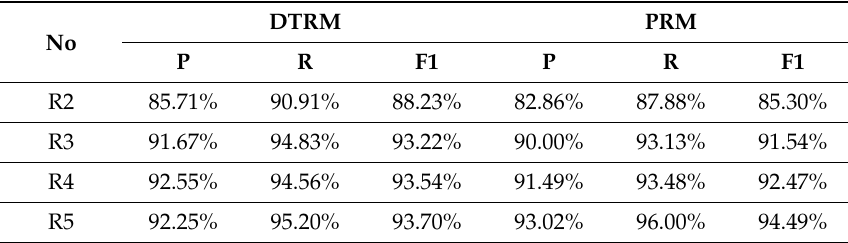
Table 4. Comparison results of DTRM and PRM in Area 2.